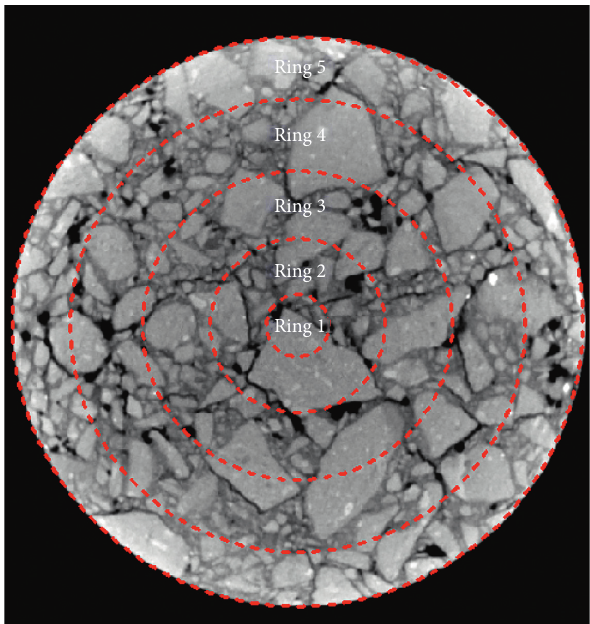
Figure 2: Segmentation of CT